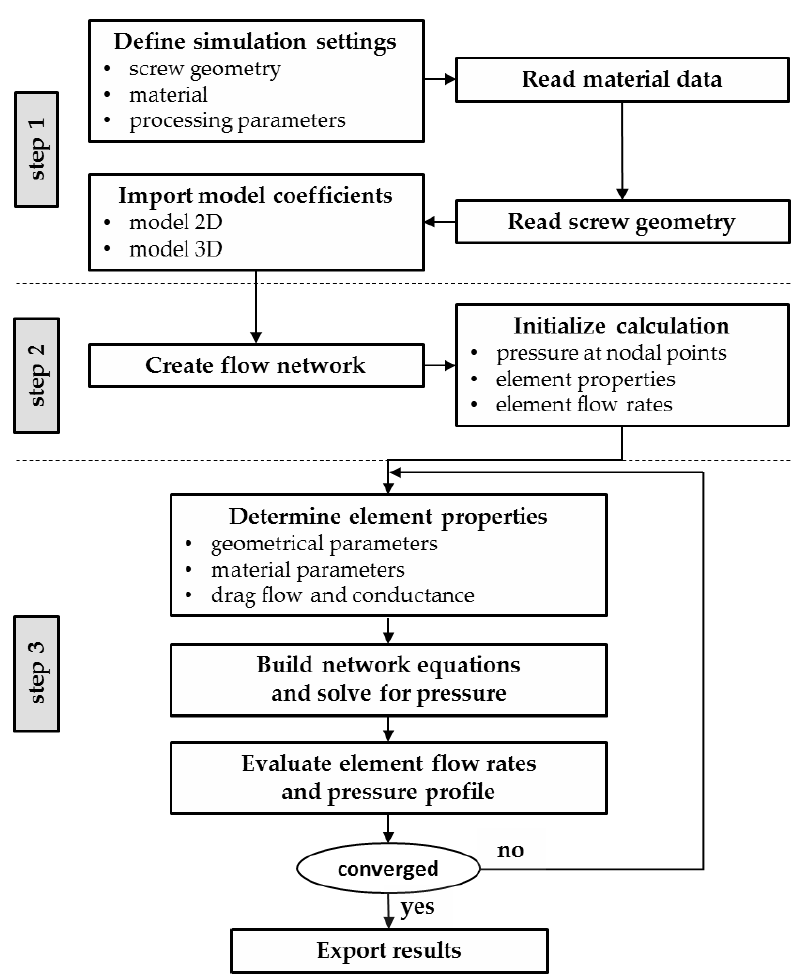
Figure 7. Flow chart of the screw-simulation